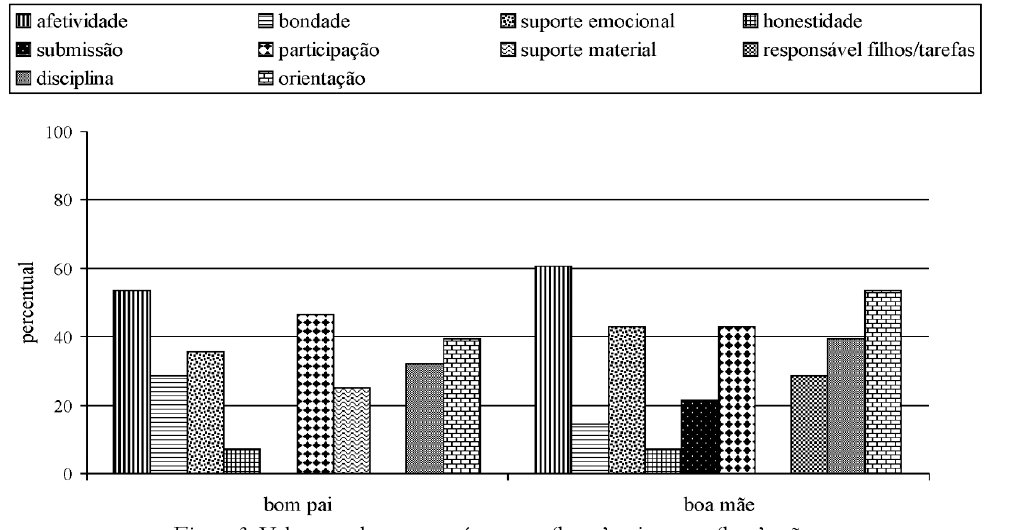
Figura 3. Valores sobre o que Ø ser um (cid:145)bom(cid:146) pai e uma (cid:145)boa(cid:146)